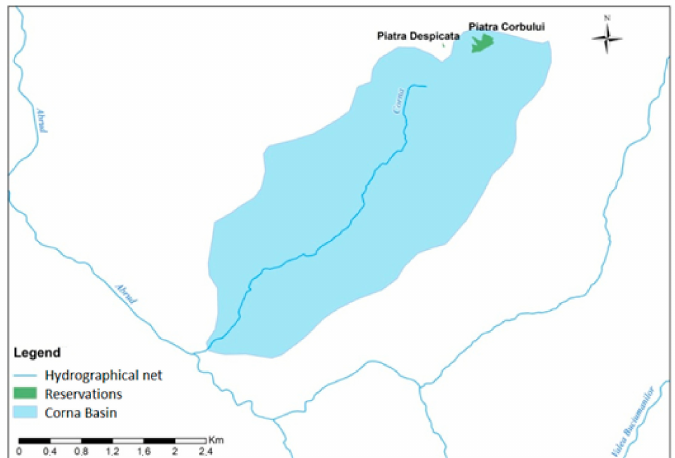
Figure 5. Northern localization of the protected natural elements Piatra Despicat ă and Piatra Corbului in the context of the Corna Valley